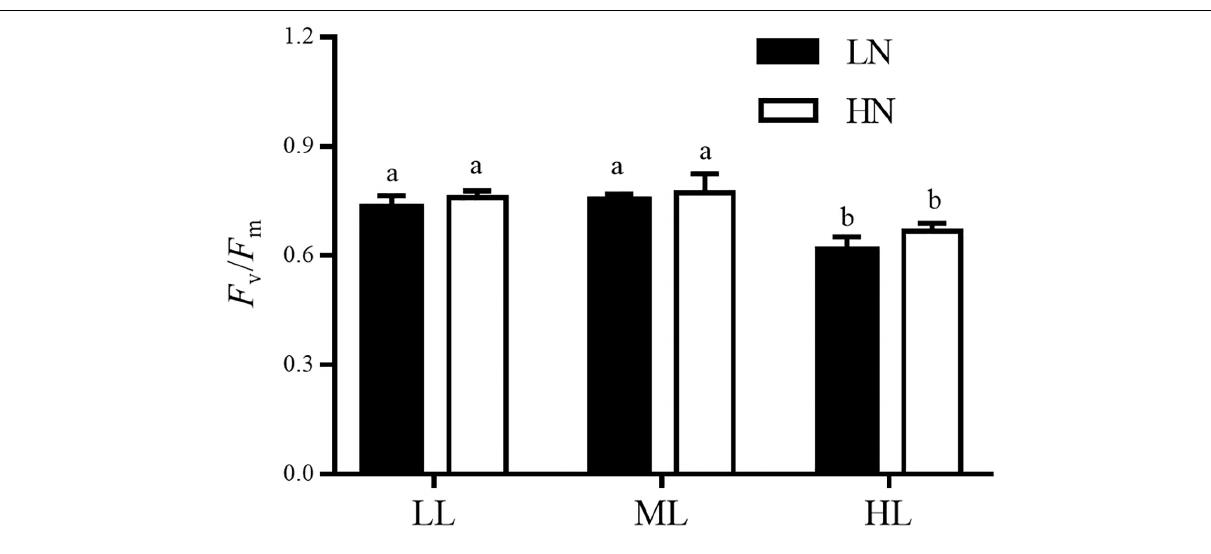
FIGURE 3 | The maximum quantum yield of photosystem II ( F v / F m ) in S. muticum grown at different light and nitrogen levels for 12 days. Significant ( P < 0.05) differences among the treatments are indicated by different lowercase letters. Vertical bars represent ± SD for the means of three